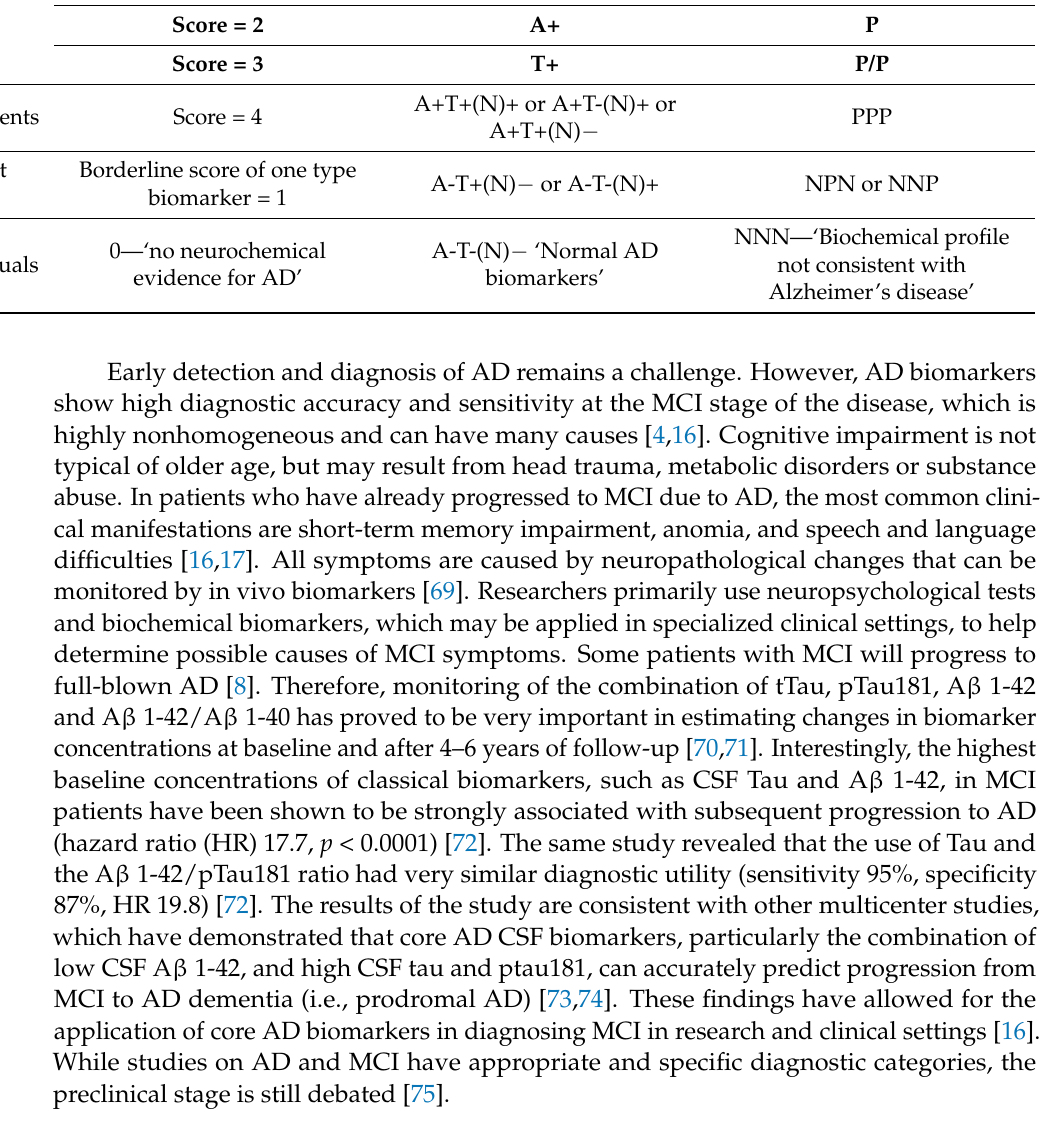
Table 1. Comparison between different interpretation scales and scores for highly probable AD, improbable or not inconsistent and healthy individuals. Abbreviations: A+ positive amyloid concen- tration, A − negative amyloid concentration, T+ positive results of tau concentration, T − negative